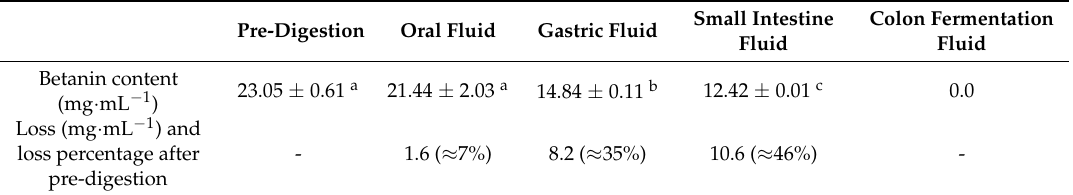
Table 1. Betanin concentrations during in vitro simulated gastrointestinal